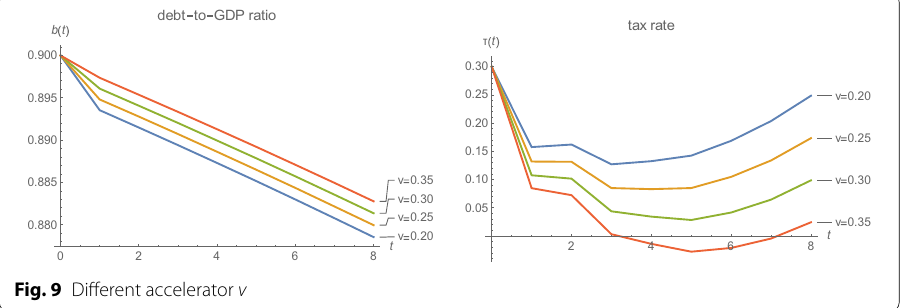
Fig. 9 Different accelerator v